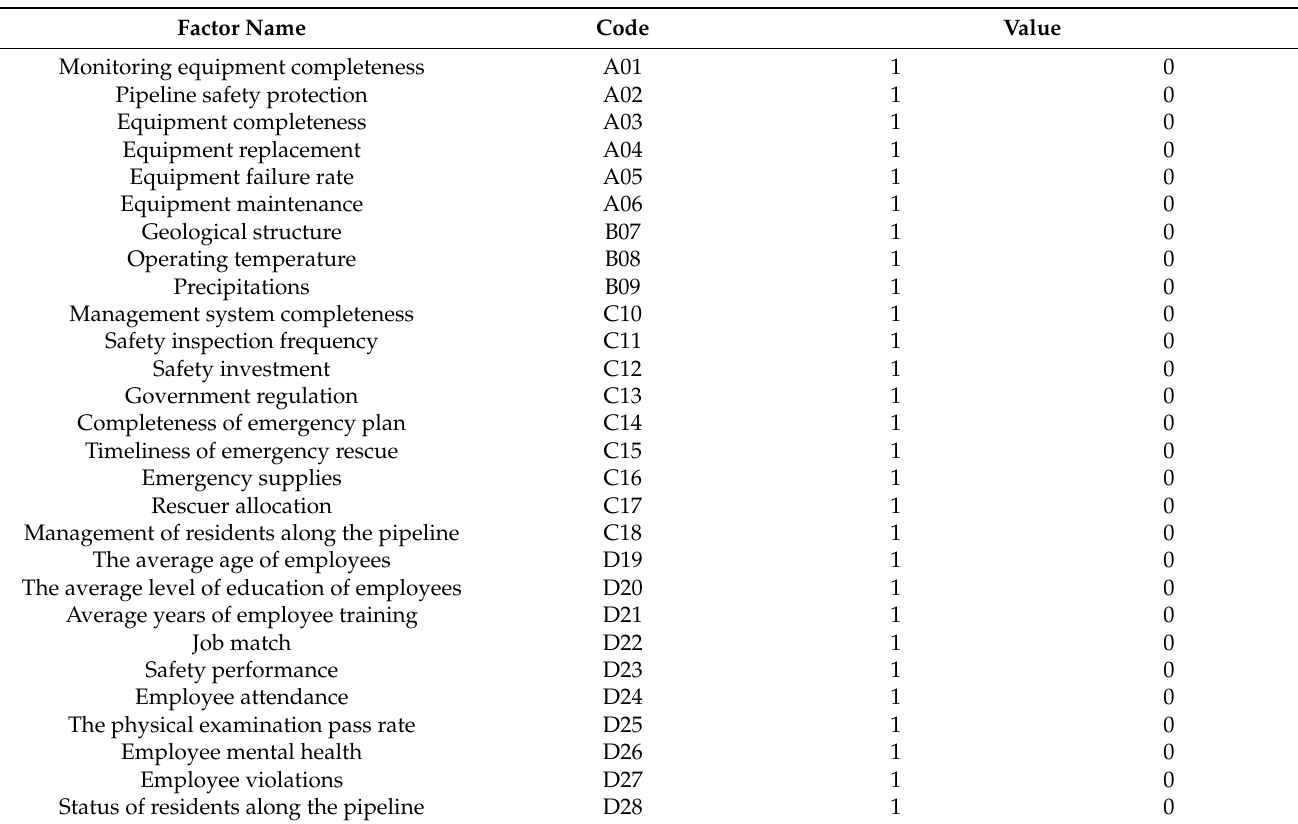
Table 1. Risk factor property